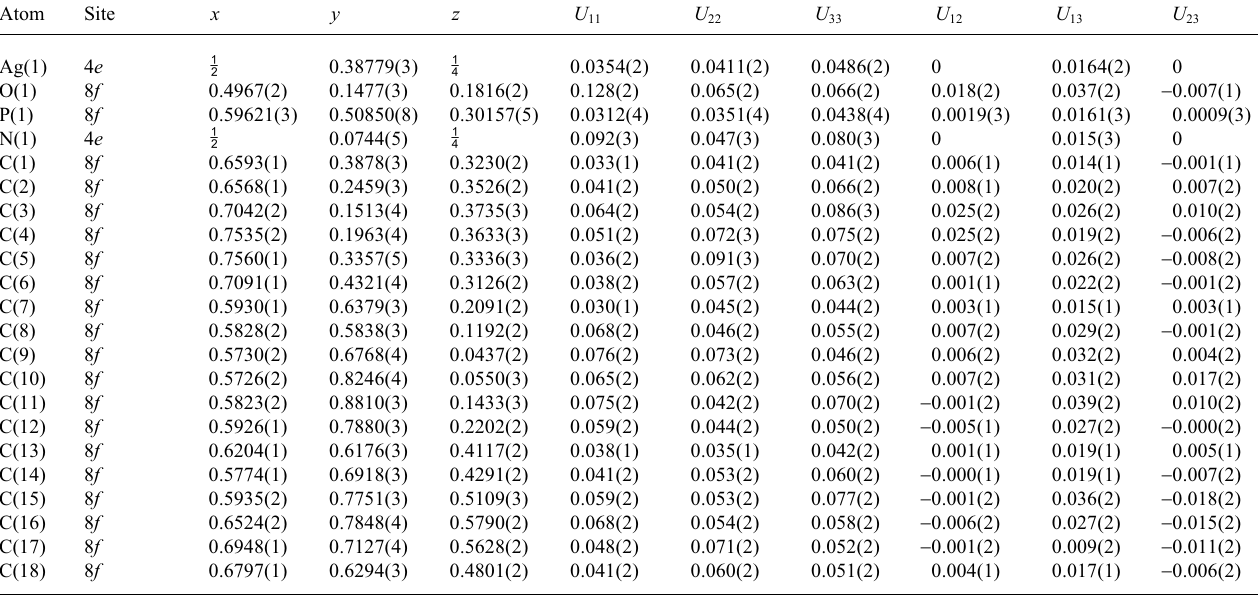
Table 3. Atomic coordinates and displacement parameters (in Å 2 )